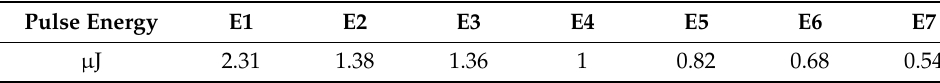
Table 1. Laser-pulse energy levels used to treat ex vivo pig